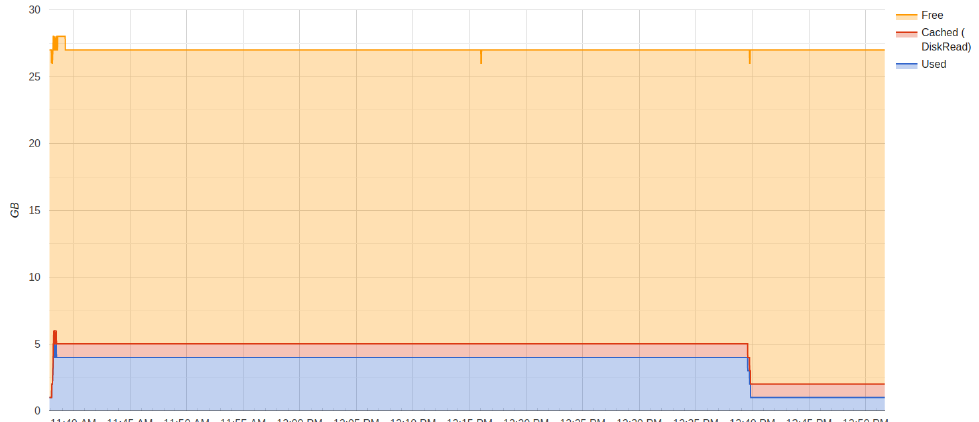
Figure 6. RAM usage of EmuCD running BitTorrent on 100 nodes, 50 MB file.